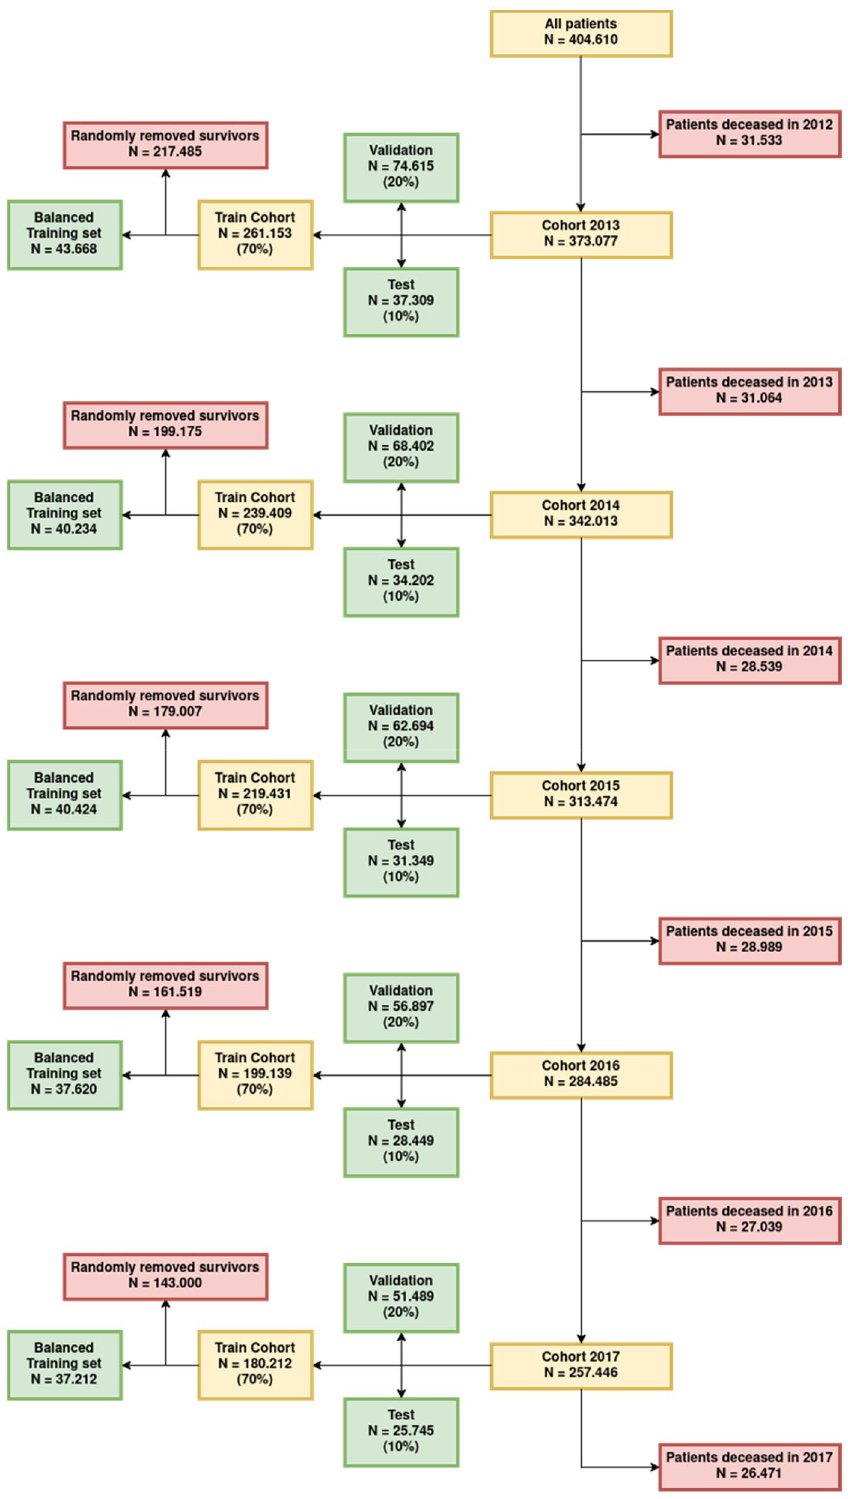
Figure 1. Flow of the data. Each combination of follow-up and time distance allowed for different datasets. The dataset used for training a model contained the maximum number of patients available who survived follow-up + time–distance respectively up to the target year. Training datasets have been created by randomly removing surviving patients such that their sample size matched that of deceased individuals. Positive target variable values were made up from patients dying during the following year. Validation and test datasets consisted of 20% and 10% of samples, including the respective amount of target values, correctly resembling the underlying